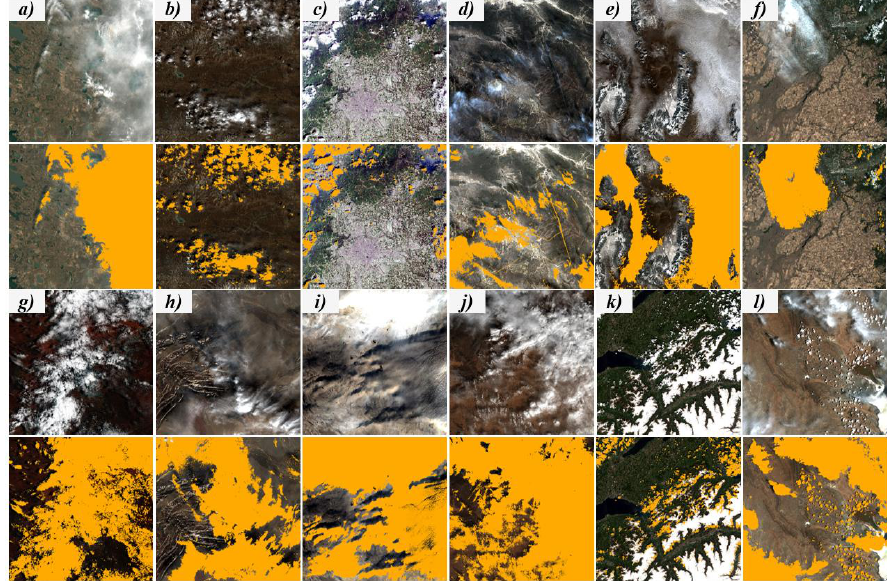
Figure 5. Cloud masks generated by CECD for 12 different Sentinel-2 scenes. ( a – l ) are the corresponding Sentinel-2 scenes from sites a to l (Table 1). The upper row is color-composited cloudy images. The lower row is the corresponding CECD cloud masks (in orange).